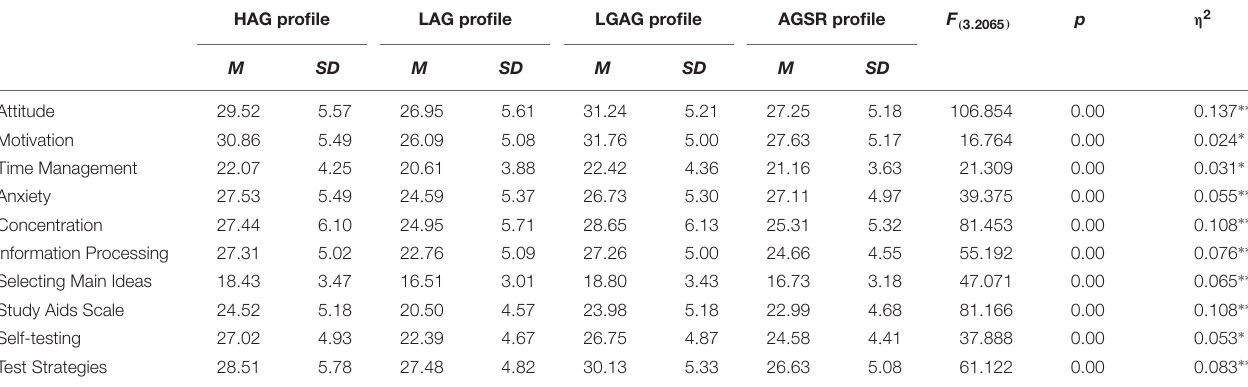
TABLE 4 | Means and standard deviations of the profiles and statistical